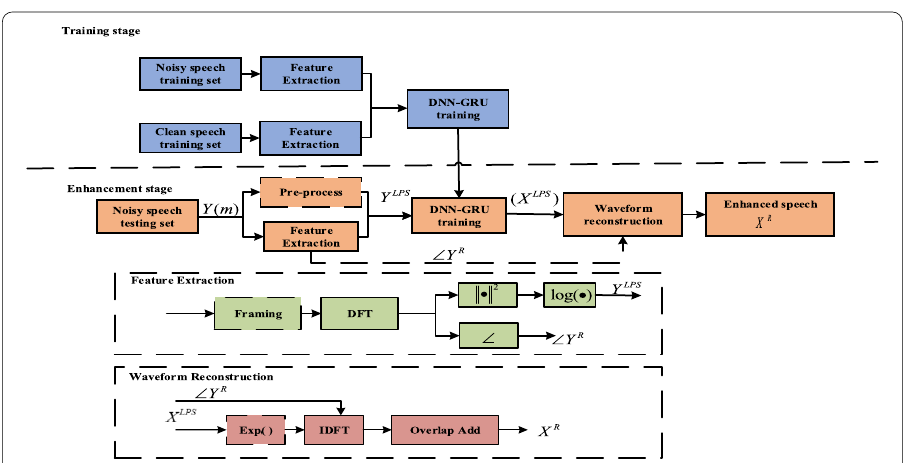
Fig. 4 Basic schematic diagram of speech enhancement method based on DNN-GRU